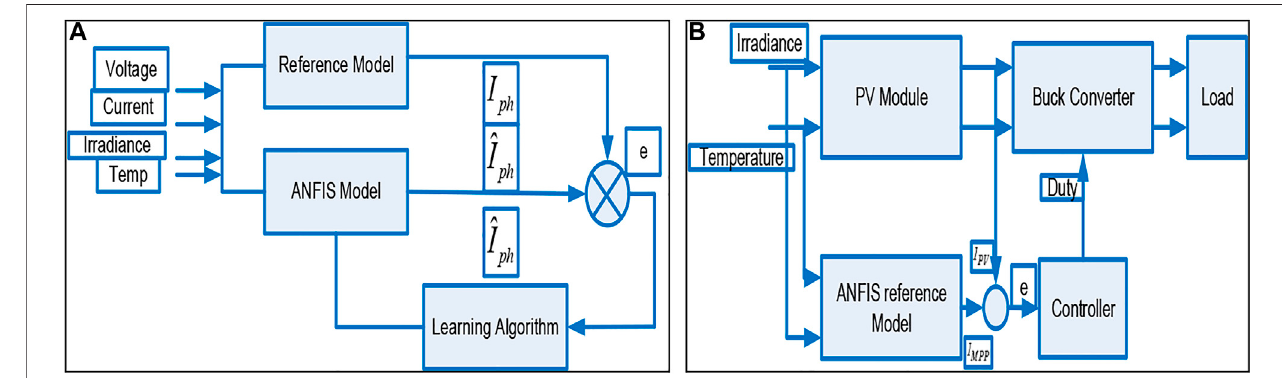
FIGURE 2 | (A,B) . ANFIS structure with different input parameters.